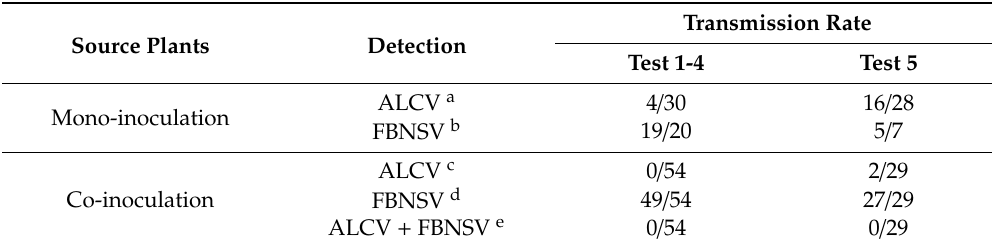
Table 2. Co-transmission testing of FBNSV and